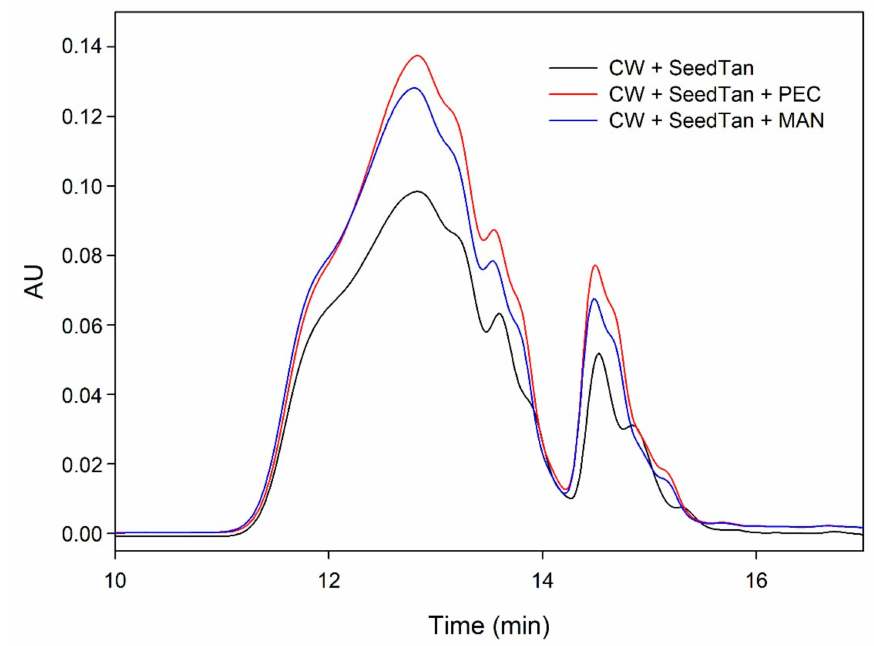
Figure 4. SEC analysis of the mass distribution of seed tannins in the presence of CW. Comparison of the seed tannins in the absence (CW + SeedTan) and presence of PEC and